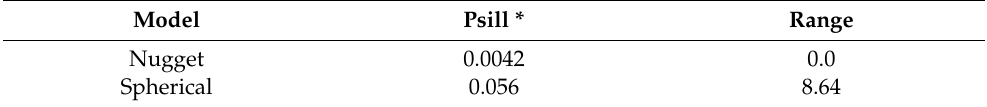
Table 8. Variogram model and parameters.